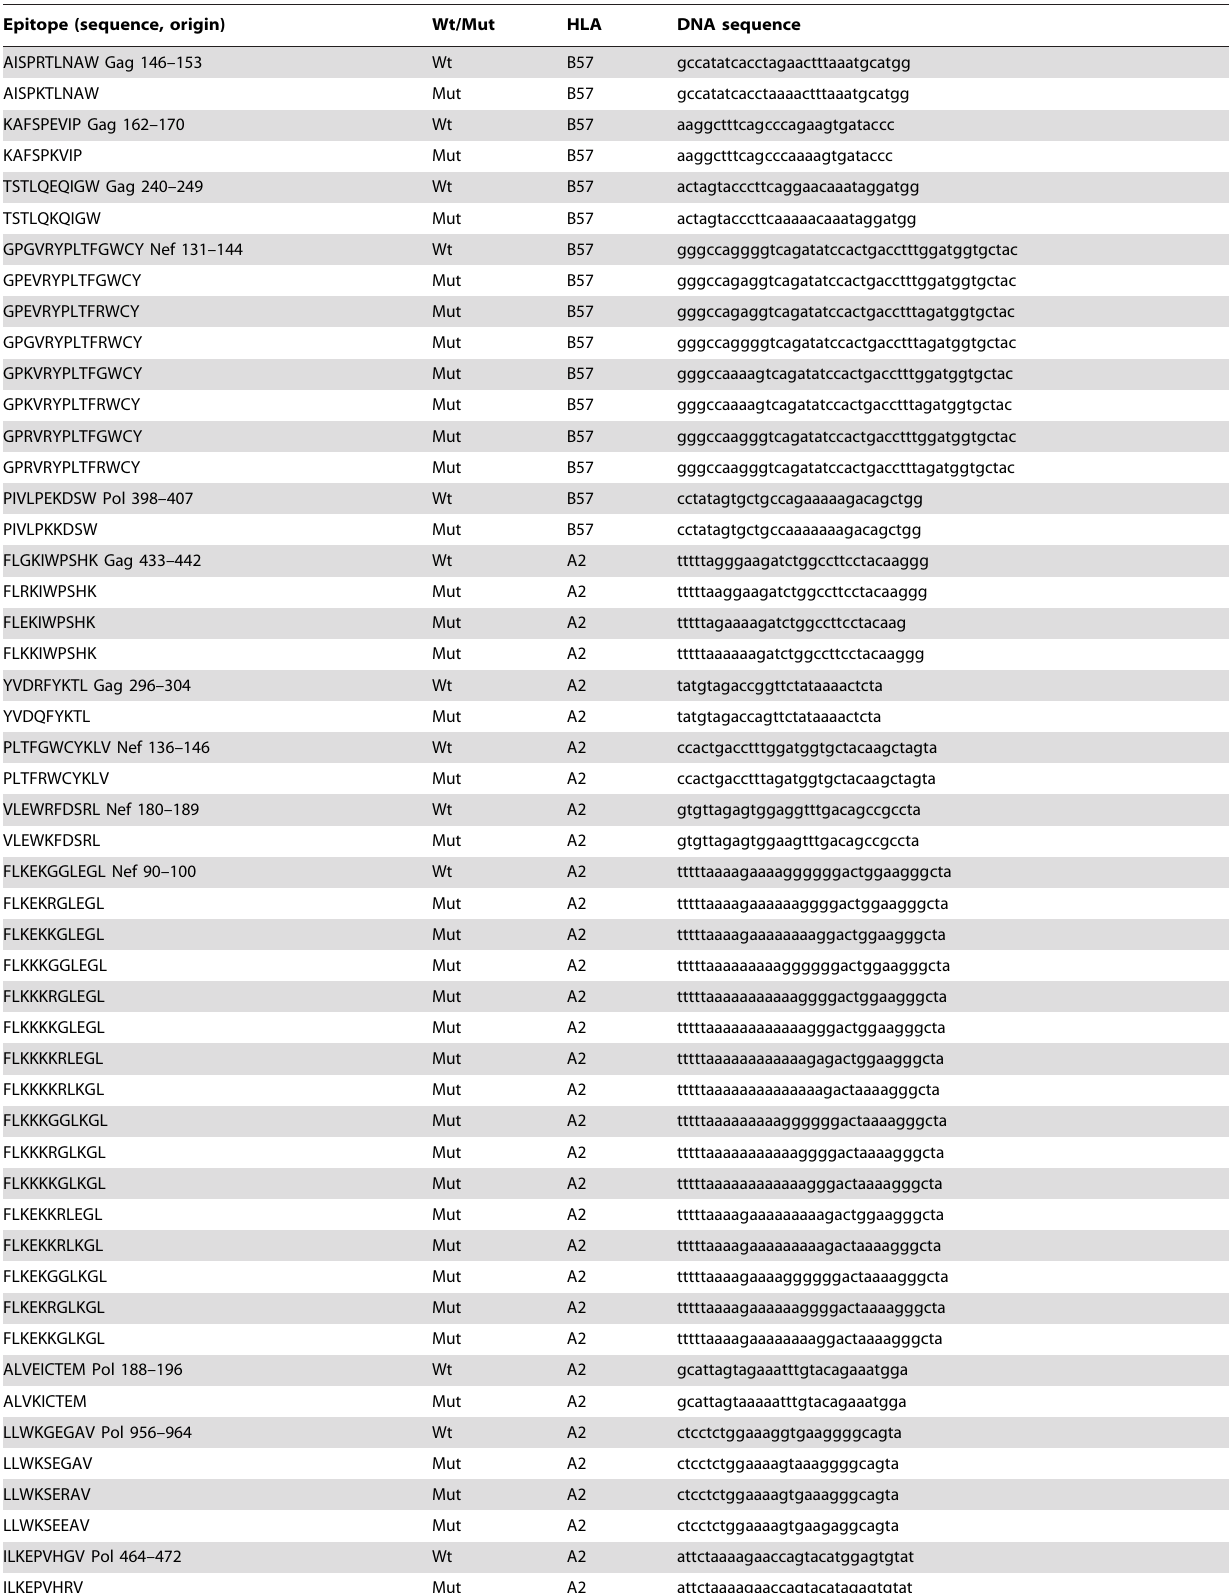
Epitope (sequence,